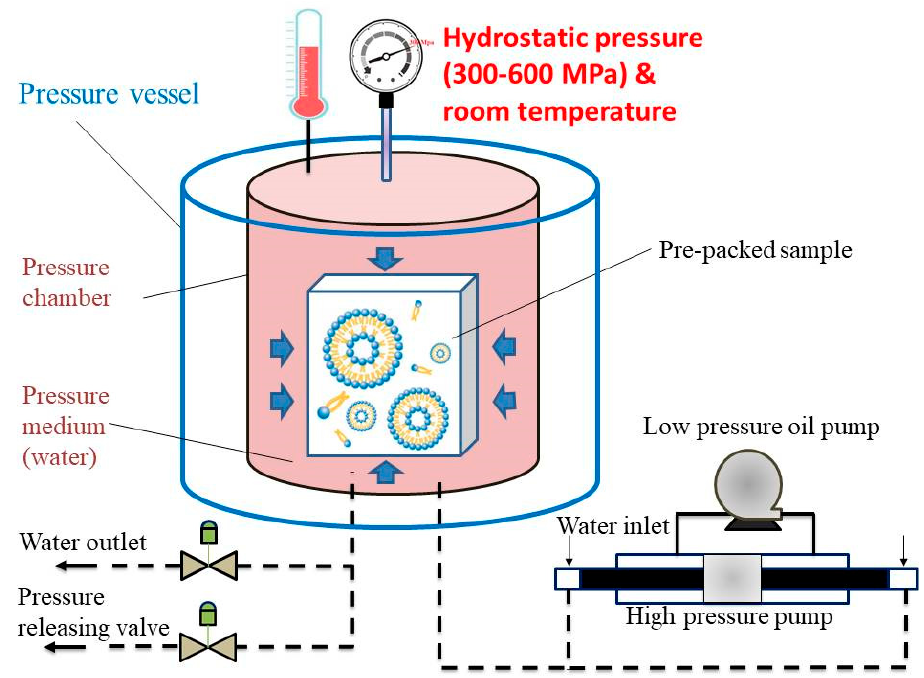
Figure 1. The schematic diagram of the high-pressure processing (HPP).